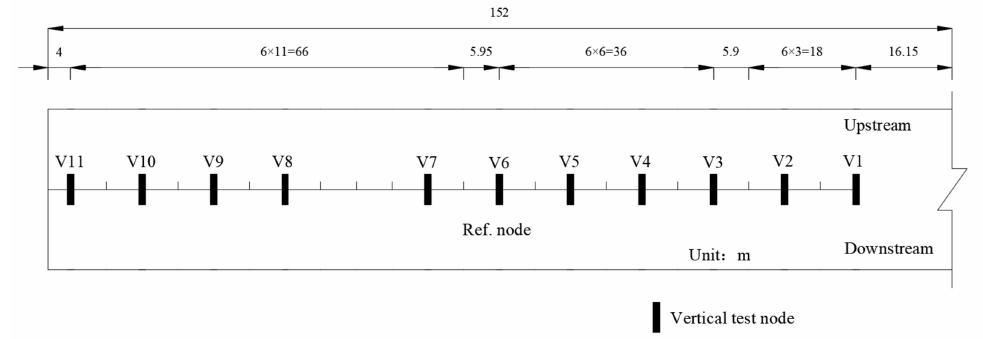
Figure 5. Measurement setup of the girder (1/4 span).